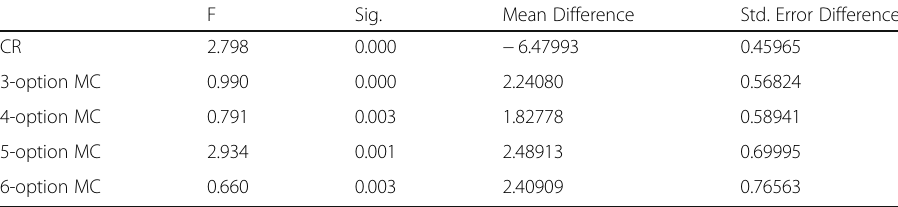
Table 6 Independent samples t test results for gender in CR and MC vocabulary test F Sig. Mean Difference Std. Error Difference